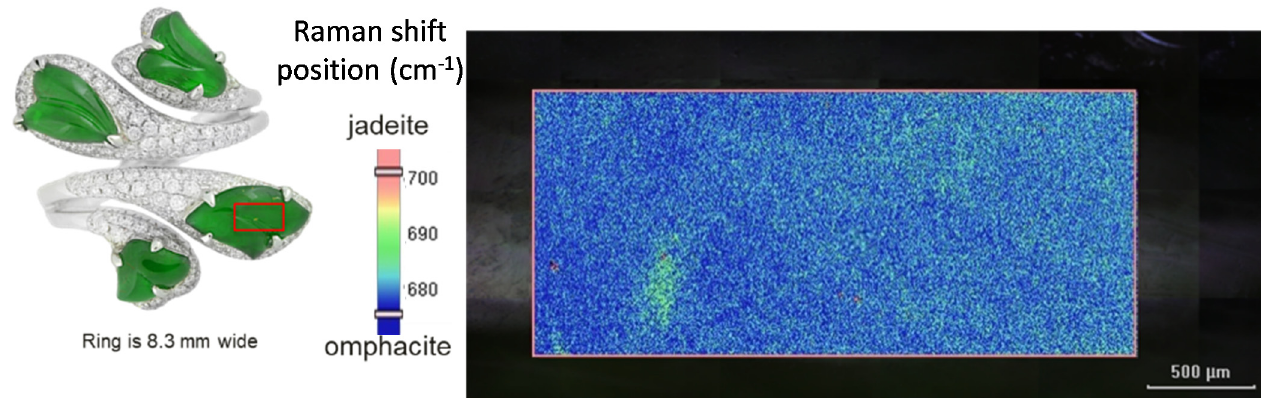
Figure 29. Raman mapping of jadeite/omphacite composition from one stone in the ring seen on the left shows a mostly uniform composition of omphacite. This ring would most often be sold as jadeite in the trade due to a relatively poor understanding of the compositional differences and the gemological difficulty in separating them. The false color map (right) ranges in color from jadeite (pink) to omphacite (blue) based on the position of the 678–700 cm − 1 primary Raman peak.